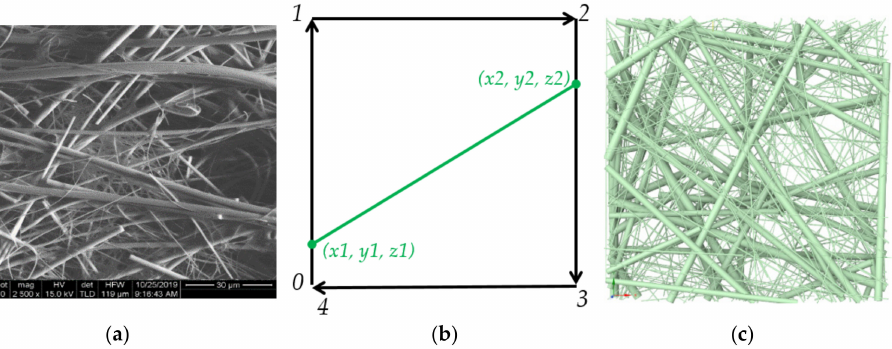
Figure 3. Fiber nonwoven mesh generation. ( a ) SEM image of meltblown glass fiber HEPA filter. ( b ) Random selection of fiber endpoints along perimeter. ( c ) Resulting digital twin